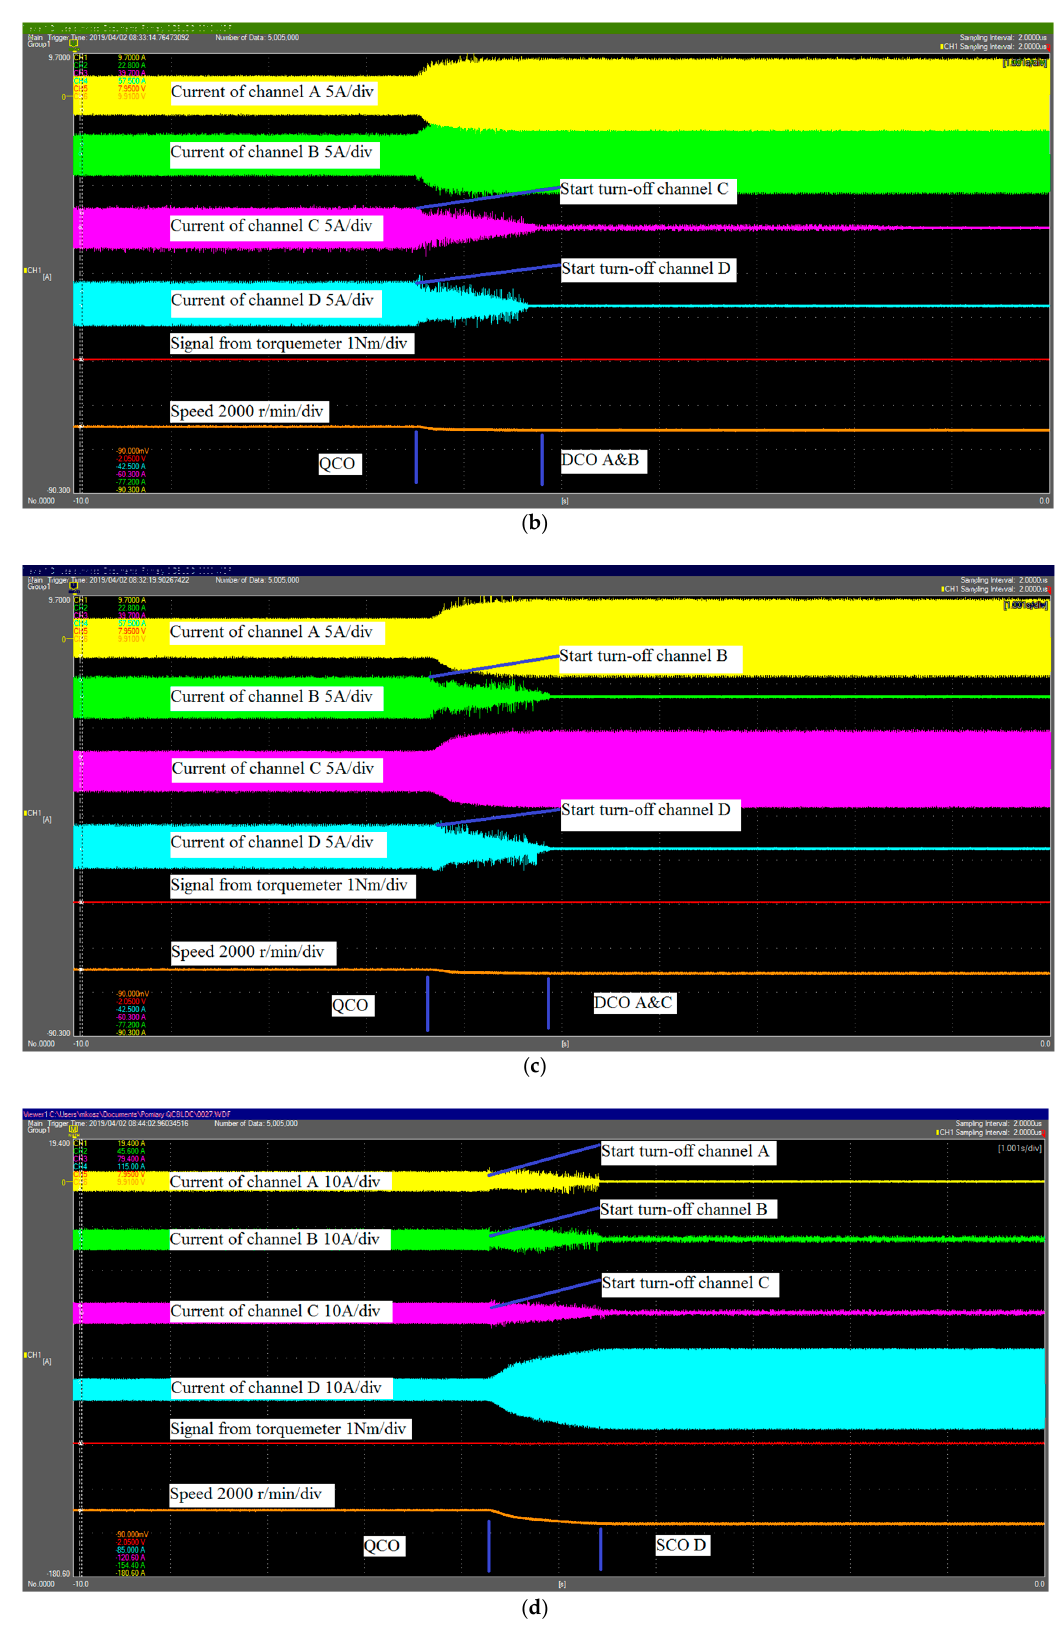
Figure 16. Waveforms of the currents, load torque, and speed for QCO in the TCO mode ( a ), the DCO A and B mode ( b ), the DCO A and C mode ( c ), and the SCO mode ( d